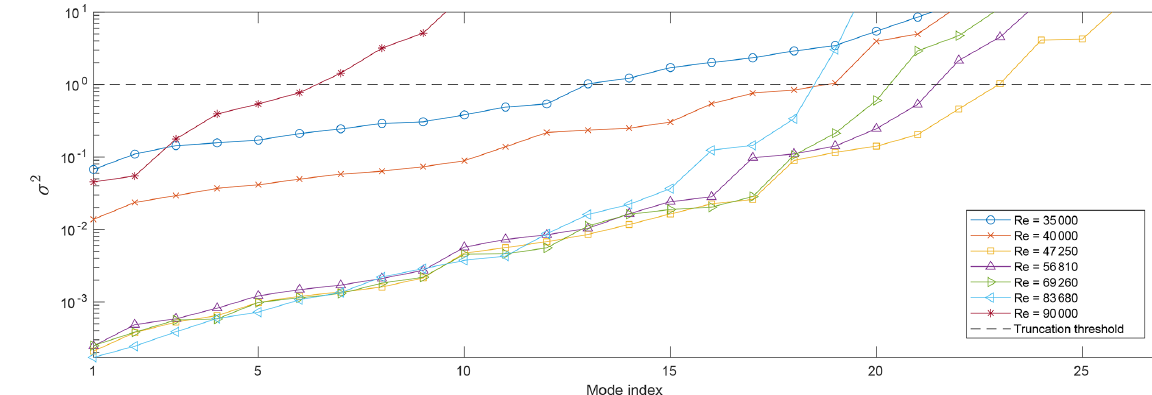
Figure 2. Variance of the lowest 25 modes for varying Reynolds.